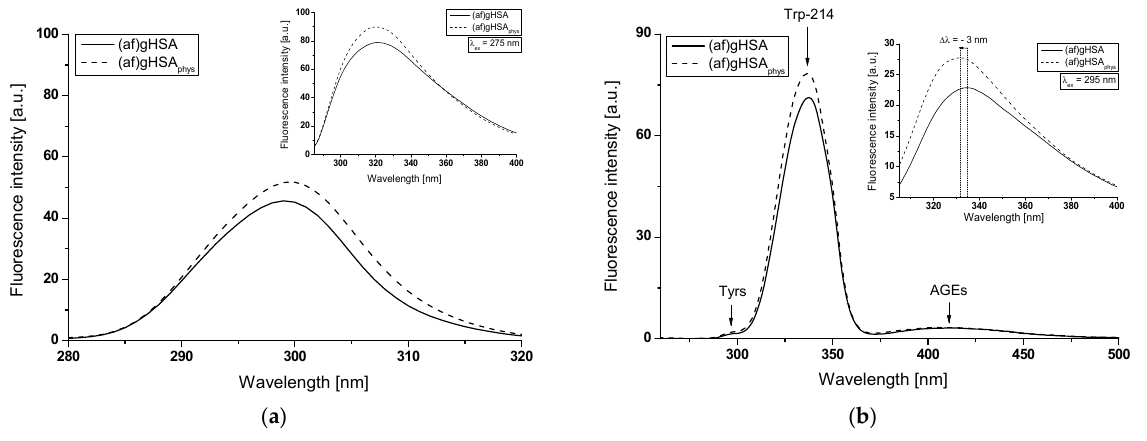
Figure 10. Main view: synchronous fluorescence spectra of (af)gHSA and (af)gHSA phys at 5 × 10 − 6 mol ∙ L − 1 concentration ( a ) Δλ = 15 nm ( λ ex = 265–305 nm) and ( b ) Δλ = 60 nm ( λ ex = 220–440 nm). Insert: comparison of (af)gHSA and (af)gHSA phys emission fluorescence spectra excited at ( a ) λ ex = 275 nm and ( b ) λ ex = 295 nm; t = 37 °C.